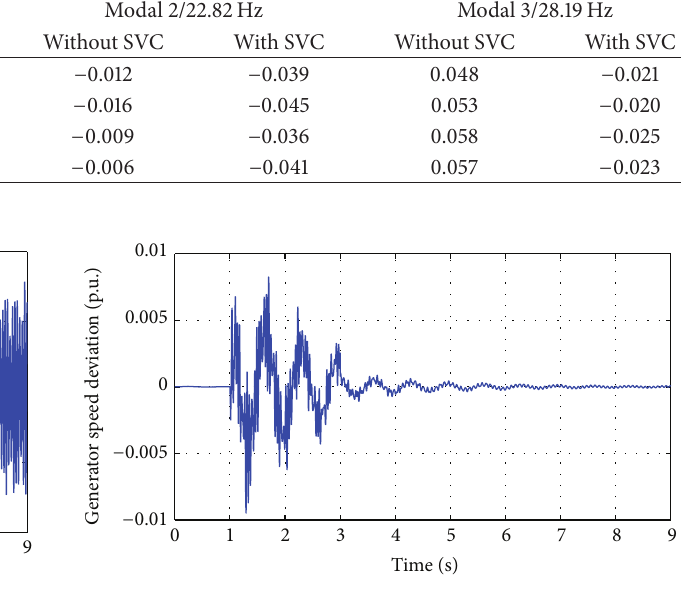
Figure 8: The generator speed deviation with SVC optimized by IBBO algorithm.